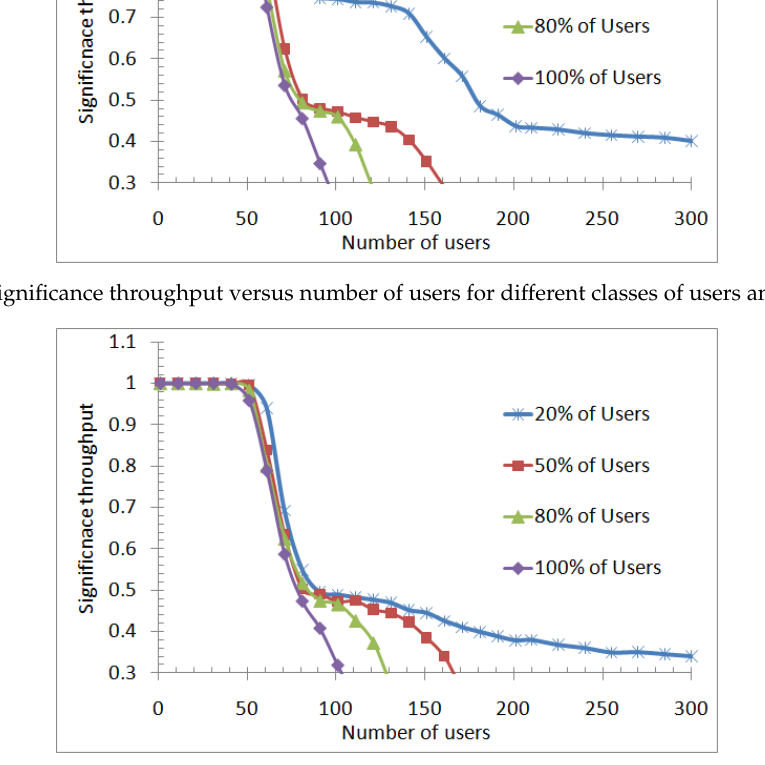
Figure 7. Significance throughput versus number of users for different classes of users and α =